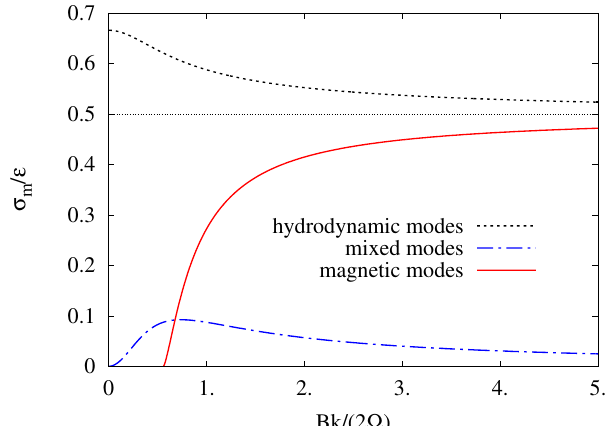
Figure 2. Variation of the maximal growth rate σ m / ε versus the local Lehner number L Ω = ω = Bk / ( 2 Ω ) for the precessing magnetohydrodynamics (MHD) instability, where A / ω R ω A = Bk (cid:107) and ω R = 2 Ω k (cid:107) / k are the frequencies of Alfvén and inertial waves, respectively. Hydrodynamic modes: σ m / ε = (cid:113) (cid:104) (cid:105) 1/ 2 ( 1 + 1 + 4 L 2 Ω ) . Mixed modes: σ m / ε = 4 L 2 Ω